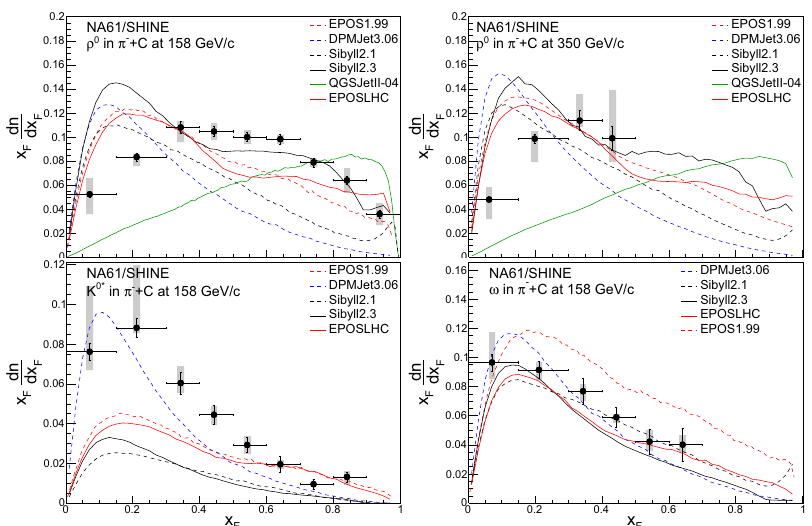
Figure 5: Spectra of ρ 0 , ω and K ∗ 0 mesons in π − + C collisions at beam momenta of 158 GeV / c and 350 GeV / c as a function of x F . The statistical uncertainties are represented by bars and the systematic ones by grey bands [22]. Regarding models see